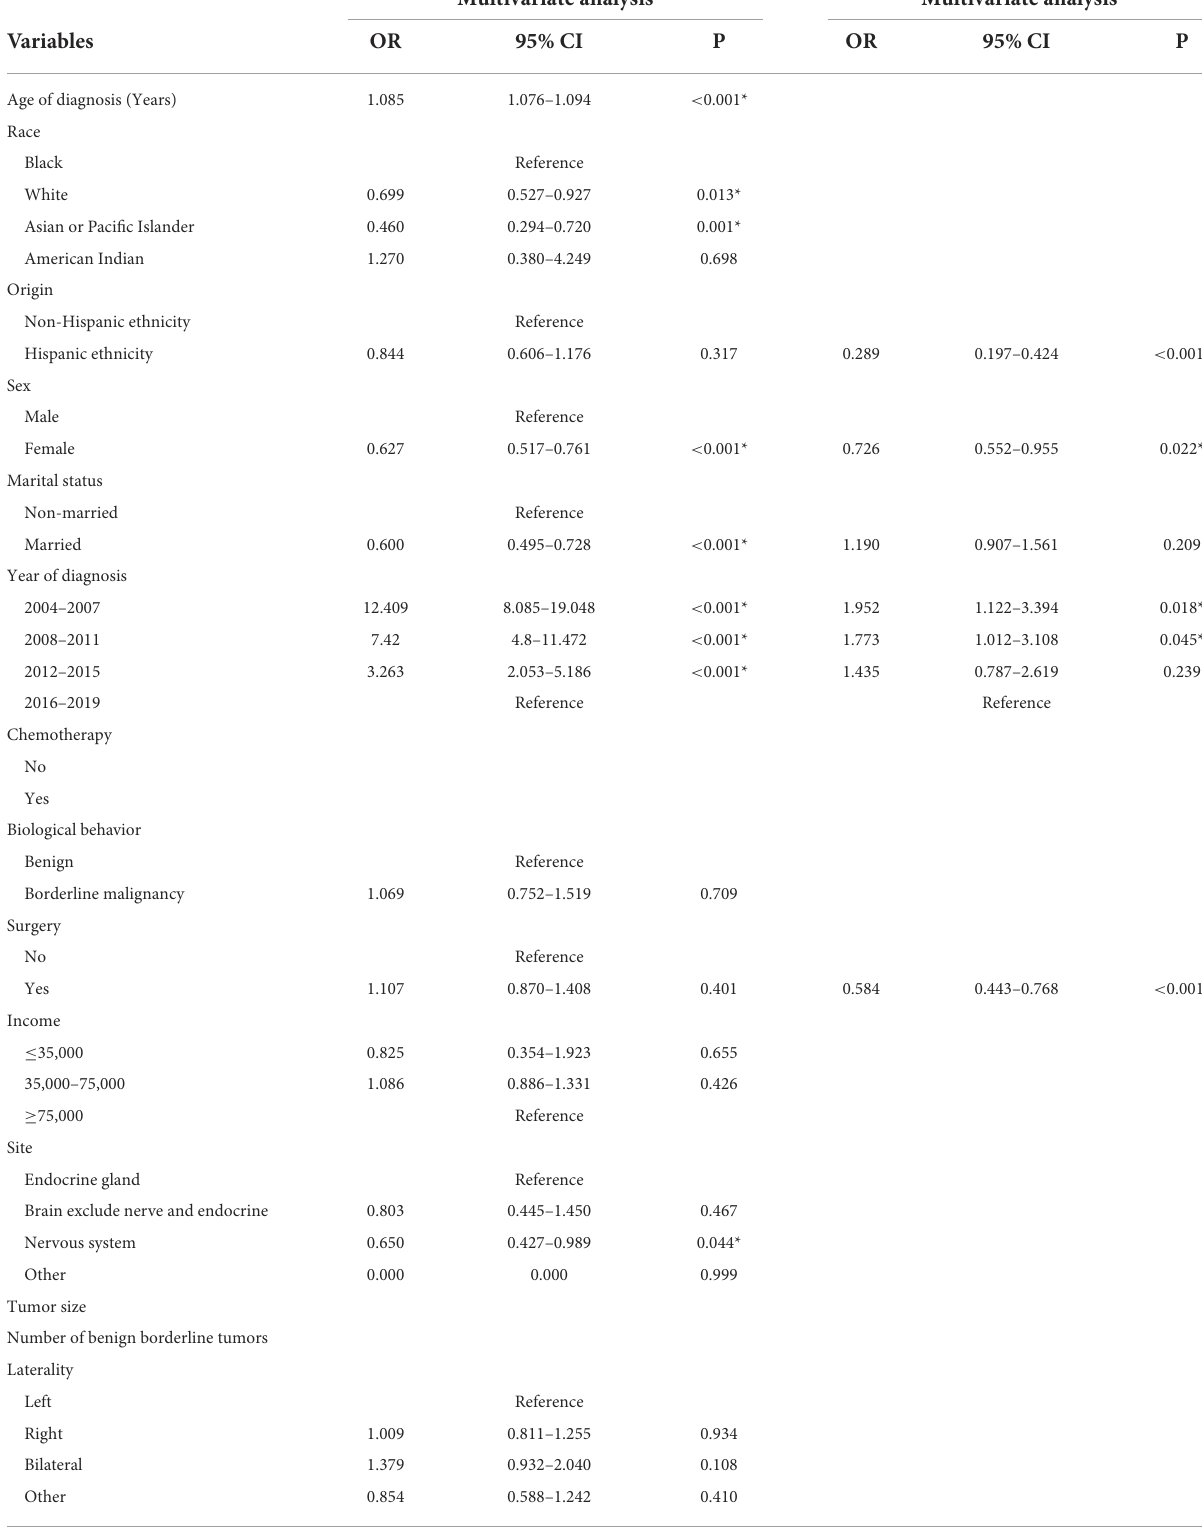
TABLE 4 Multivariate logistics regression analyses among patients with non-malignant tumors receiving RT. Before PSM After PSM Multivariate analysis Multivariate